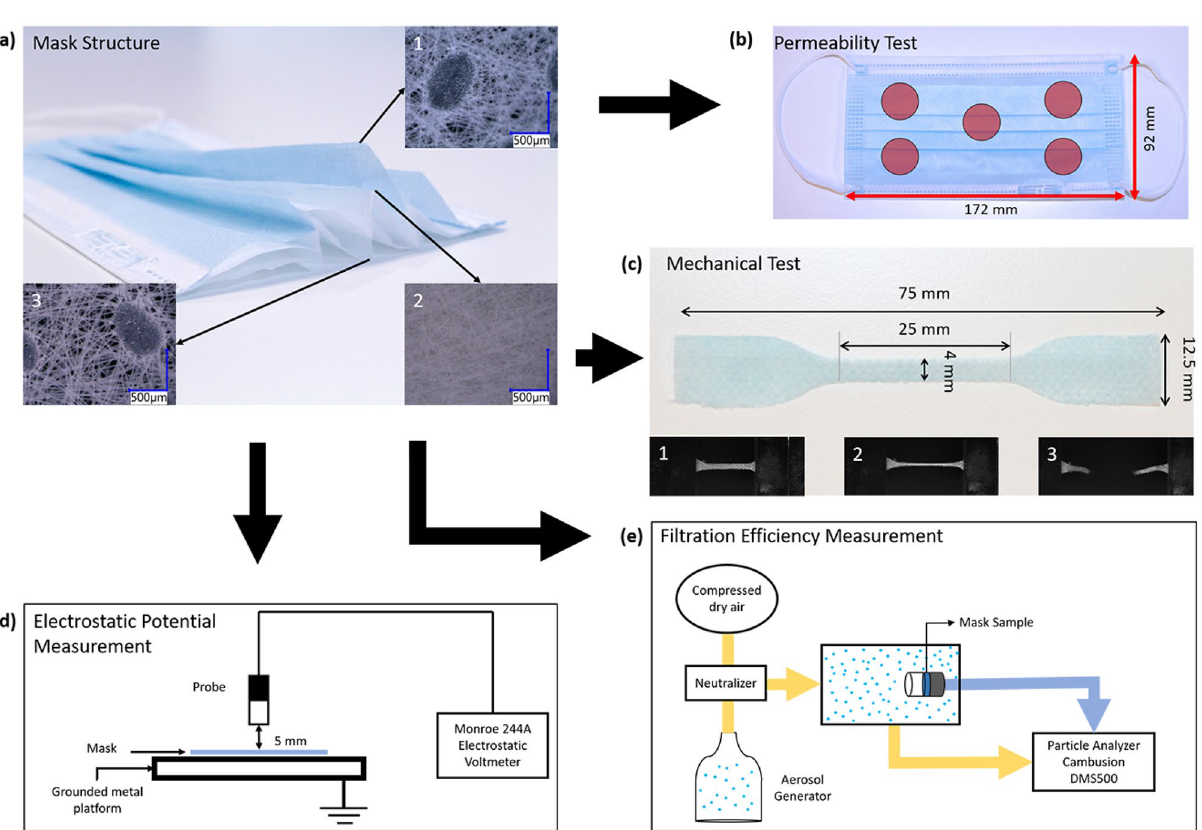
Figure 1. Schematics of mask durability characterization methods: ( a ) three layer configuration of a Type IIR surgical mask along with the micrographs of the (1) outer layer, (2) the middle layer and (3) the inner layer; ( b ) locations of the permeability measurements performed on each mask; ( c ) dimensions of the samples for the mechanical (tensile) test punched out from the masks along with pictures (1) before, (2) during and (3) after the test; ( d ) mask electrostatic potential measurement method and ( e ) filtration efficiency measurement